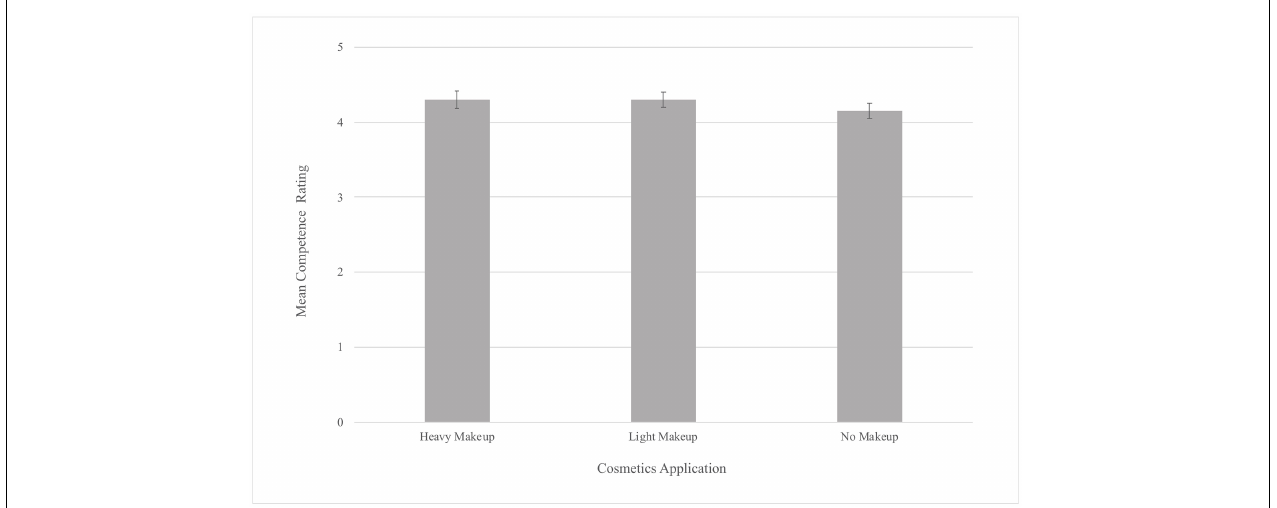
FIGURE 3 | Mean Competence Ratings by Makeup Application (error bars represent 95% confidence intervals).